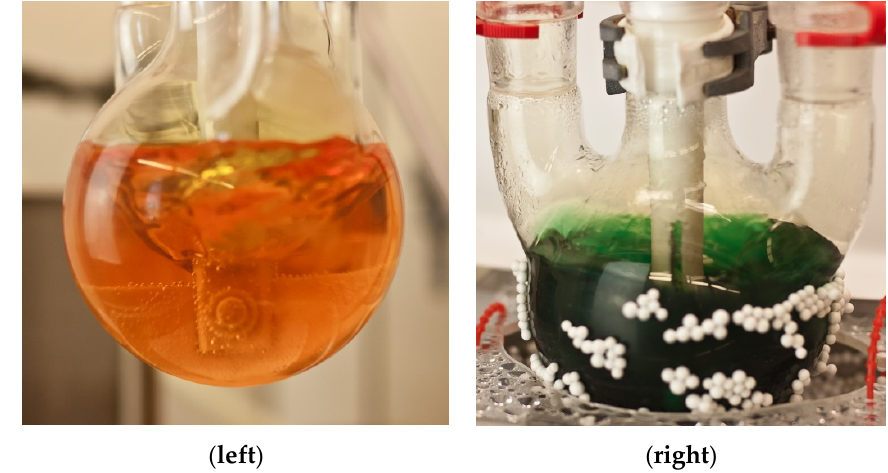
Figure 13. ( Left ): Aqua regia approximately 9 min after mixing and stirring. ( Right ): View of the reactor during the experiment, containing the PCD and cobalt bearing solution. In this case, it was running at 333 K, with full-time ultrasound and 45g/L solid-to-liquid ratio.